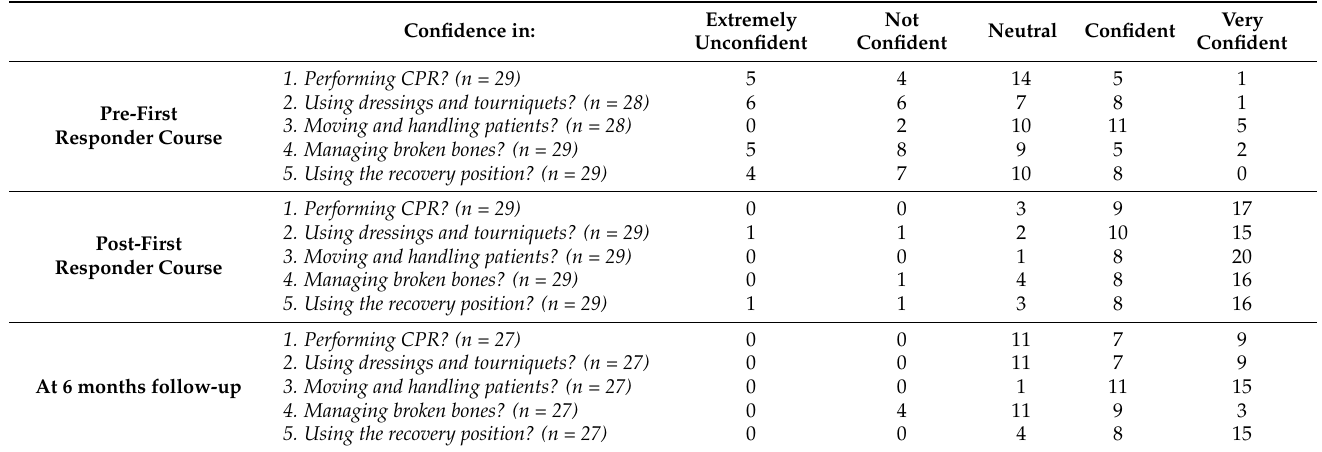
Table 3. First-Aid Confidence